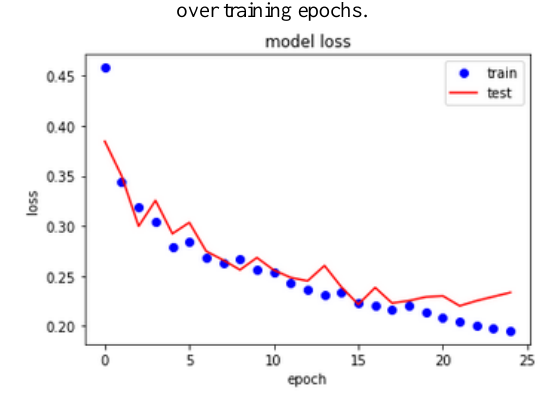
Fig.14: A plot of loss on the training and validation datasets over training